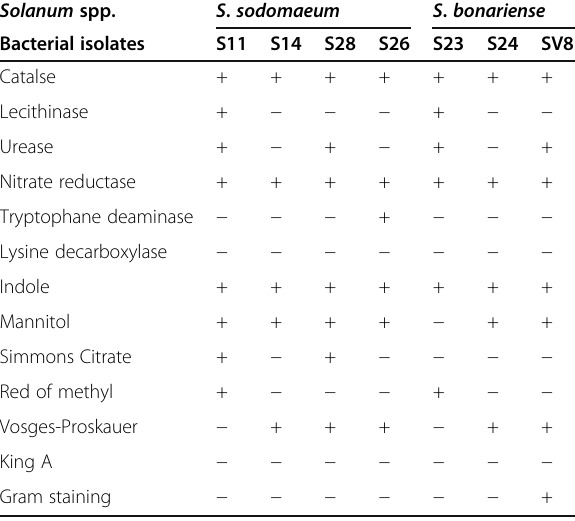
Table 1 Biochemical characterization and Gram staining of selected endophytic bacterial isolates recovered from Solanum sodomaeum and S . bonariense plants Solanum